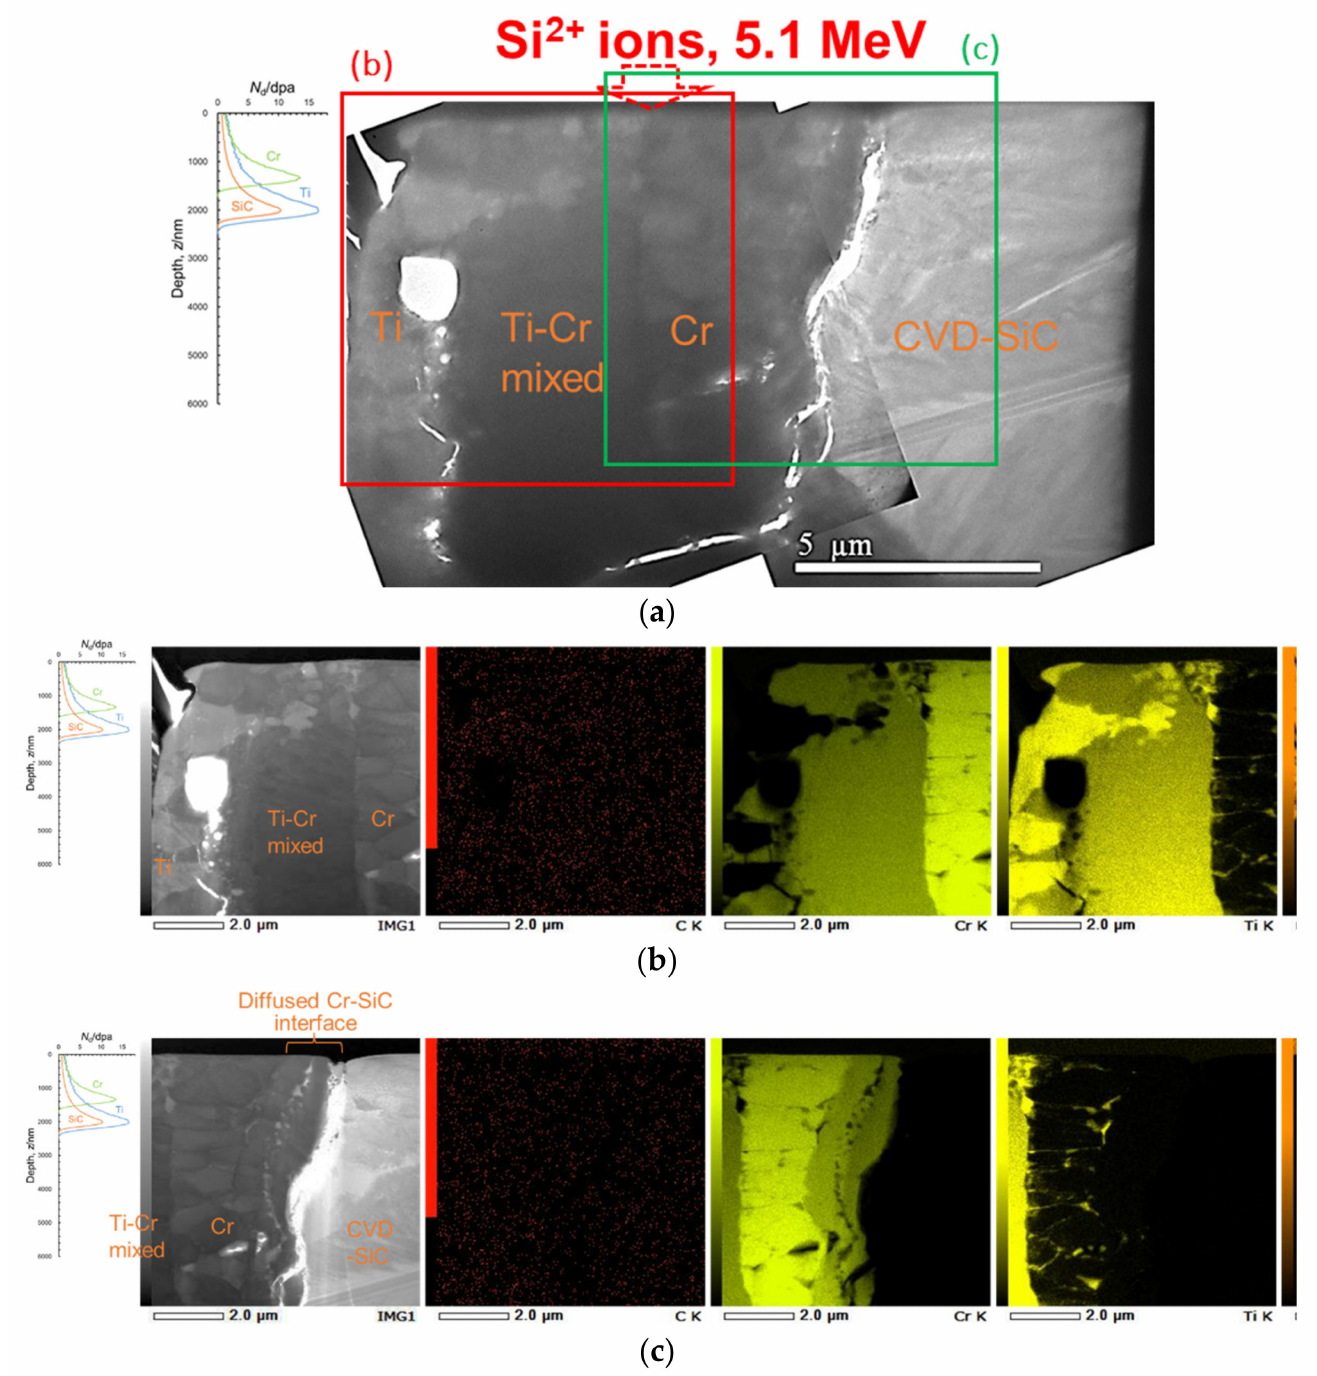
Figure 10. Cross-sectional bright field images and EDS mappings of Ti-Cr multilayer coating after being irradiated with Si 2+ ions up to a fluence of 2.85 × 10 20 ions /m 2 . ( a ) Bright field image overview. ( b , c ) Analyzed areas described in ( a ). Far left, two bright field images, the other eight images are the EDS mappings. In ( b ) Ti, Ti-Cr mixed, and Cr layers were identified and in ( c ) Ti-Cr mixed, Cr, diffused Cr-SiC interface and CVD SiC layers were